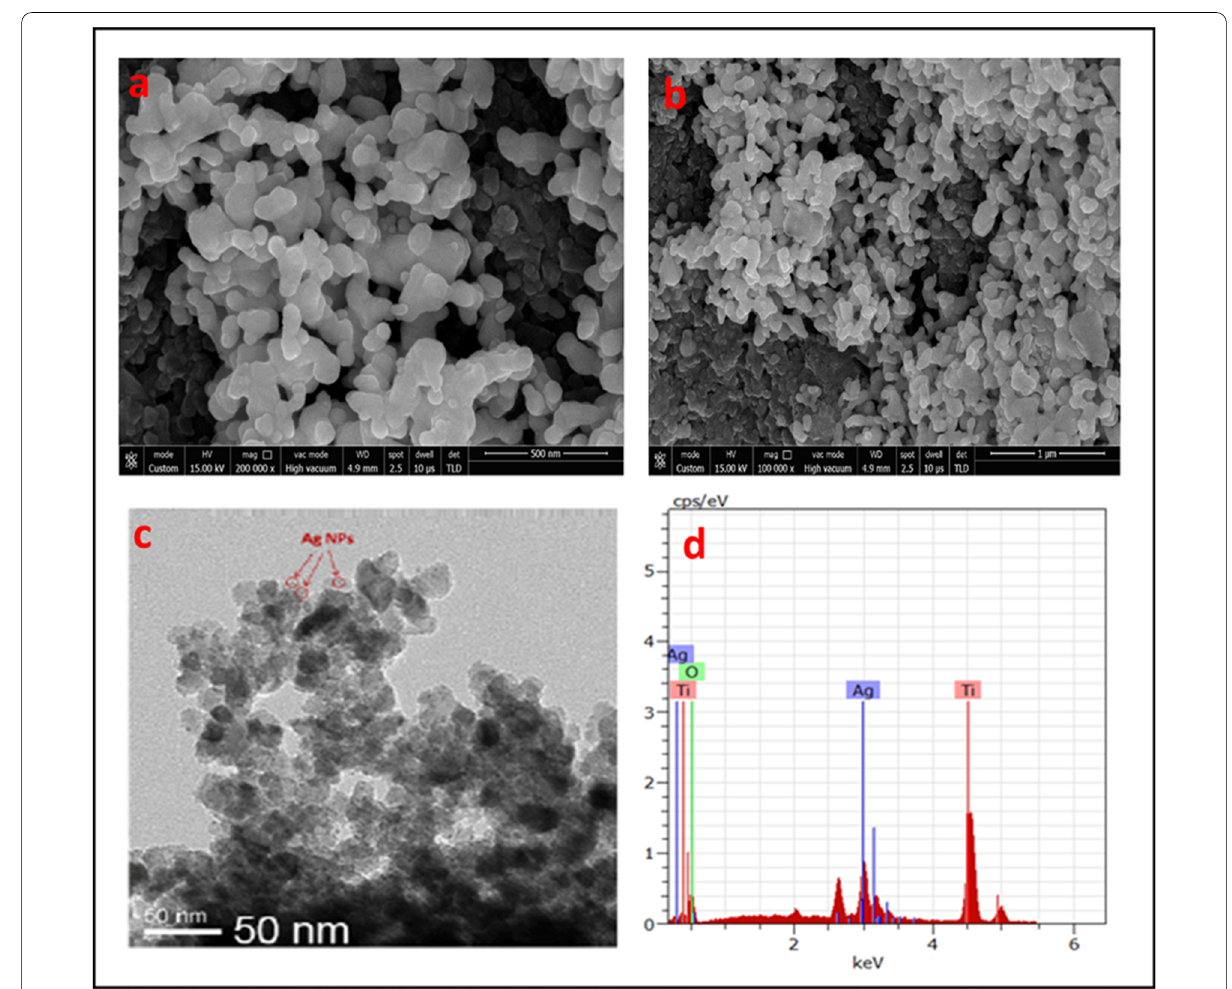
Fig. 4 a SEM image of Ag–TiO 2 NCs with magnification at 500 nm; b SEM image of Ag–TiO 2 NCs with magnification at 1 µm; c TEM image of Ag– TiO 2 NCs; d EDS spectrum of green-synthesised Ag–TiO 2